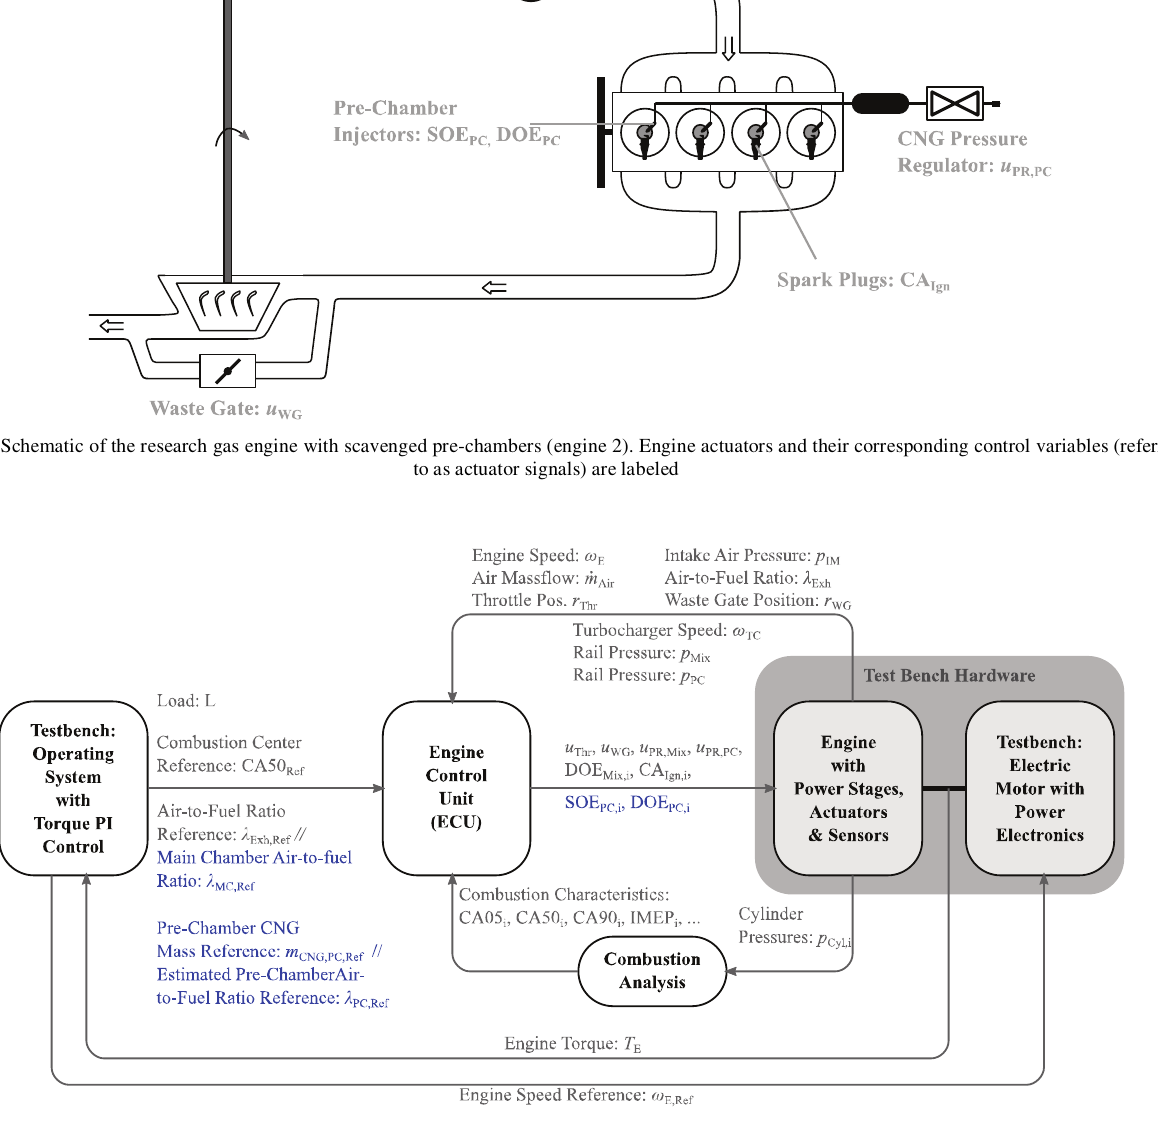
Fig. 2. Test bench setup of the research engines with the main signal flows used for the engine control. The test bench operating system sets four reference signals and the ECU uses feedback control to operate the engine accordingly. The blue reference and actuator signals are needed additionally for engine 2 with scavenged pre-chambers